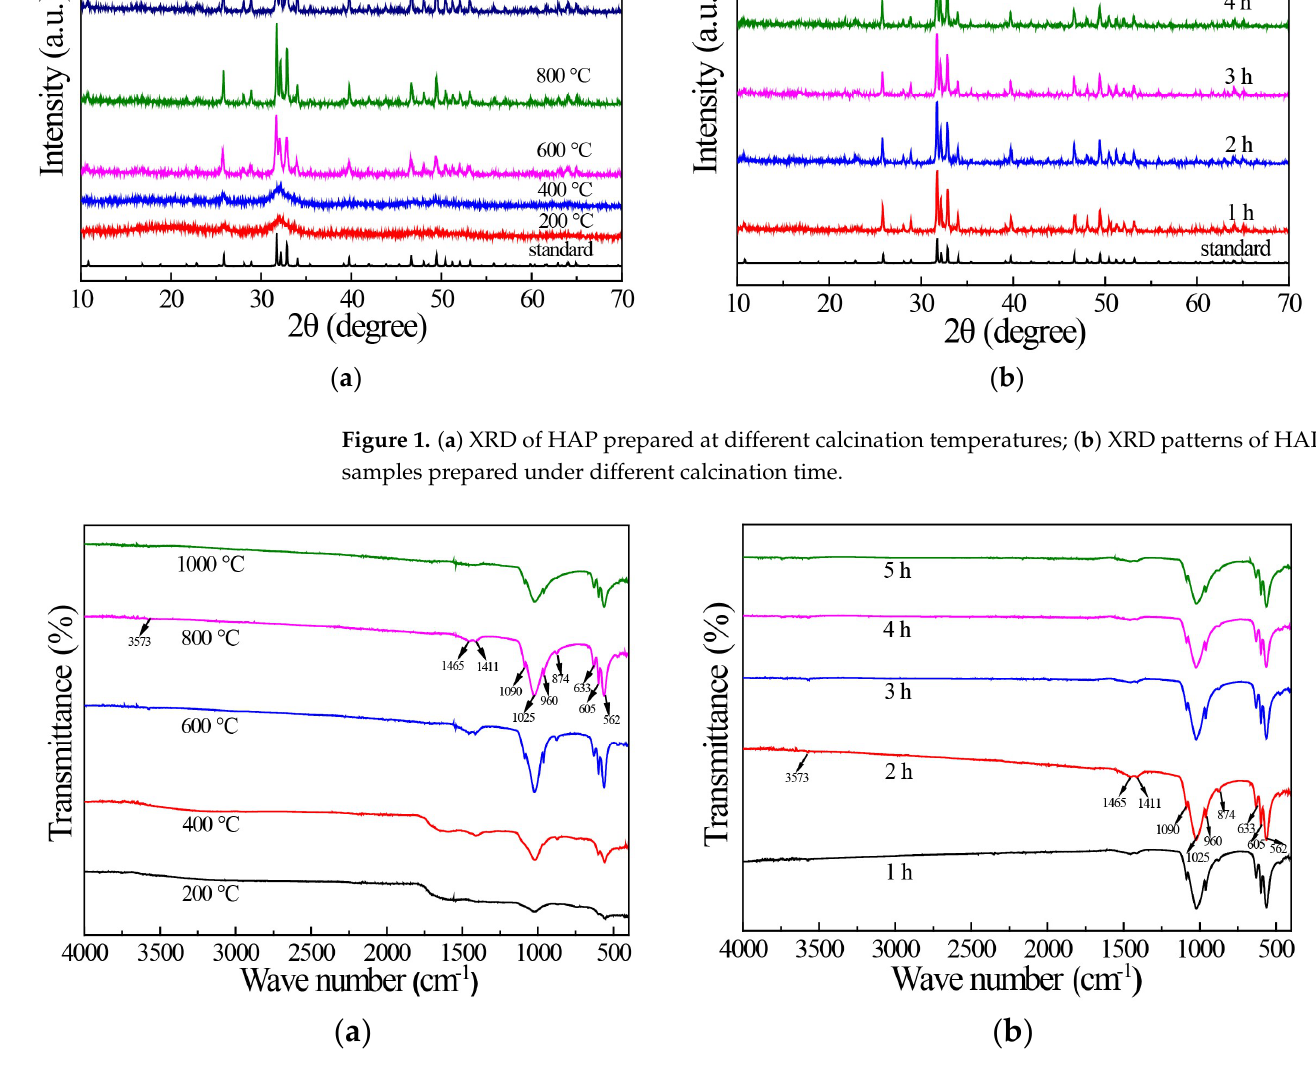
Figure 2. FTIR diagram of HAP prepared at different calcination temperatures ( a ) and for different calcination time ( b ).